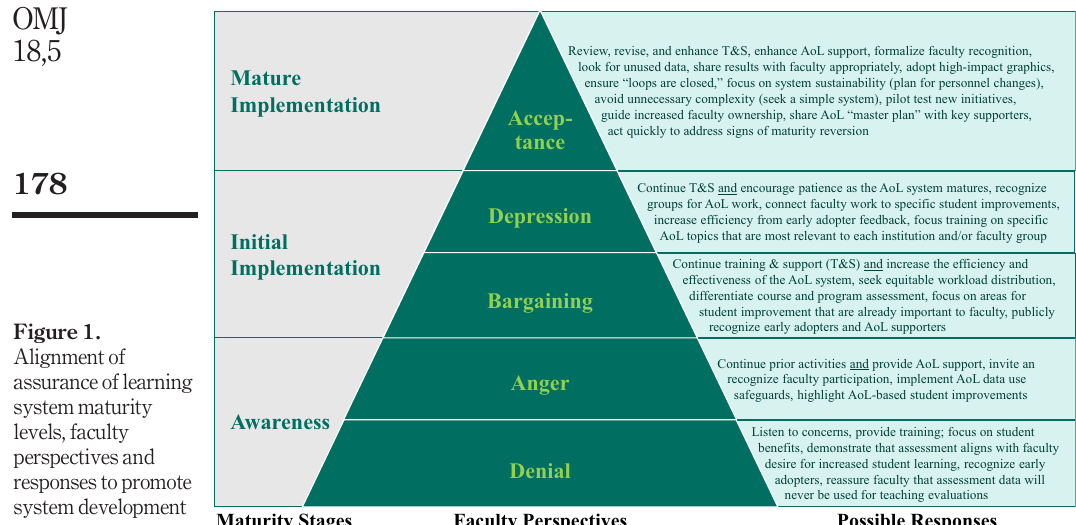
Figure 1. Alignment